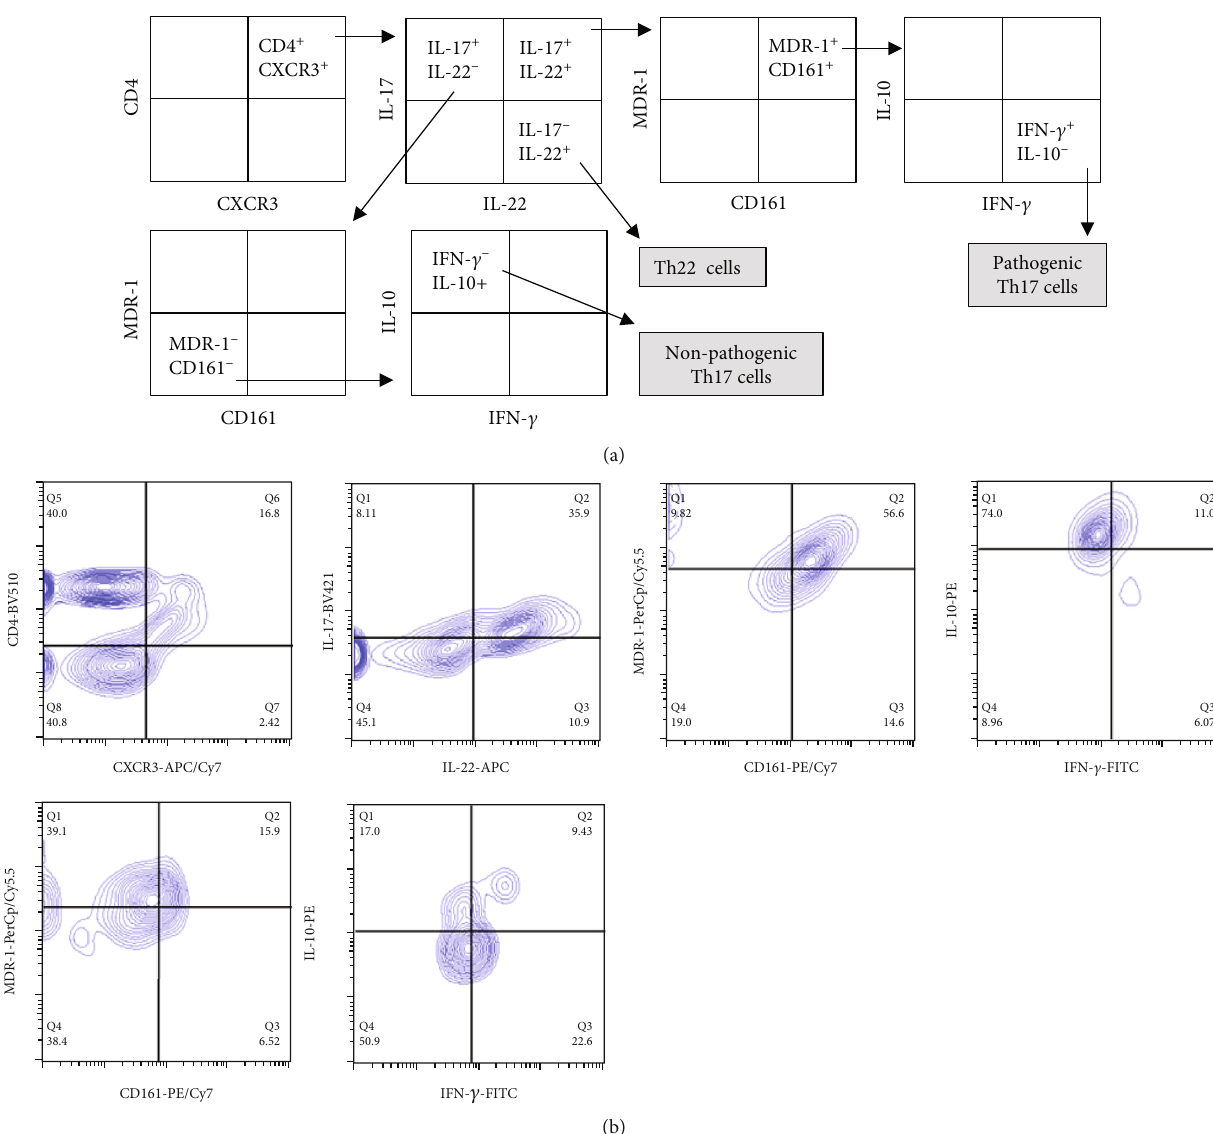
Figure 1: Flow cytometry strategy for the analysis of Th17 and Th22 cells. (a) PBMC were labeled with MoAbs against CD4, CXCR3, IL-17, IL-22, CD243 (MDR-1), CD161, IFN- γ , and IL-10 and analyzed by multiparametric fl ow cytometry, as indicated. This analysis allowed to detect the cell subsets of interest, pathogenic Th17 cells, nonpathogenic Th17 cells, and Th22 lymphocytes. (b) Flow cytometry images of a representative analysis of a blood sample from a healthy donor are shown. The type of fl uorochrome coupled to each antibody is indicated, and the negative stain controls were selected according to the fl uorescence minus one (FMO)